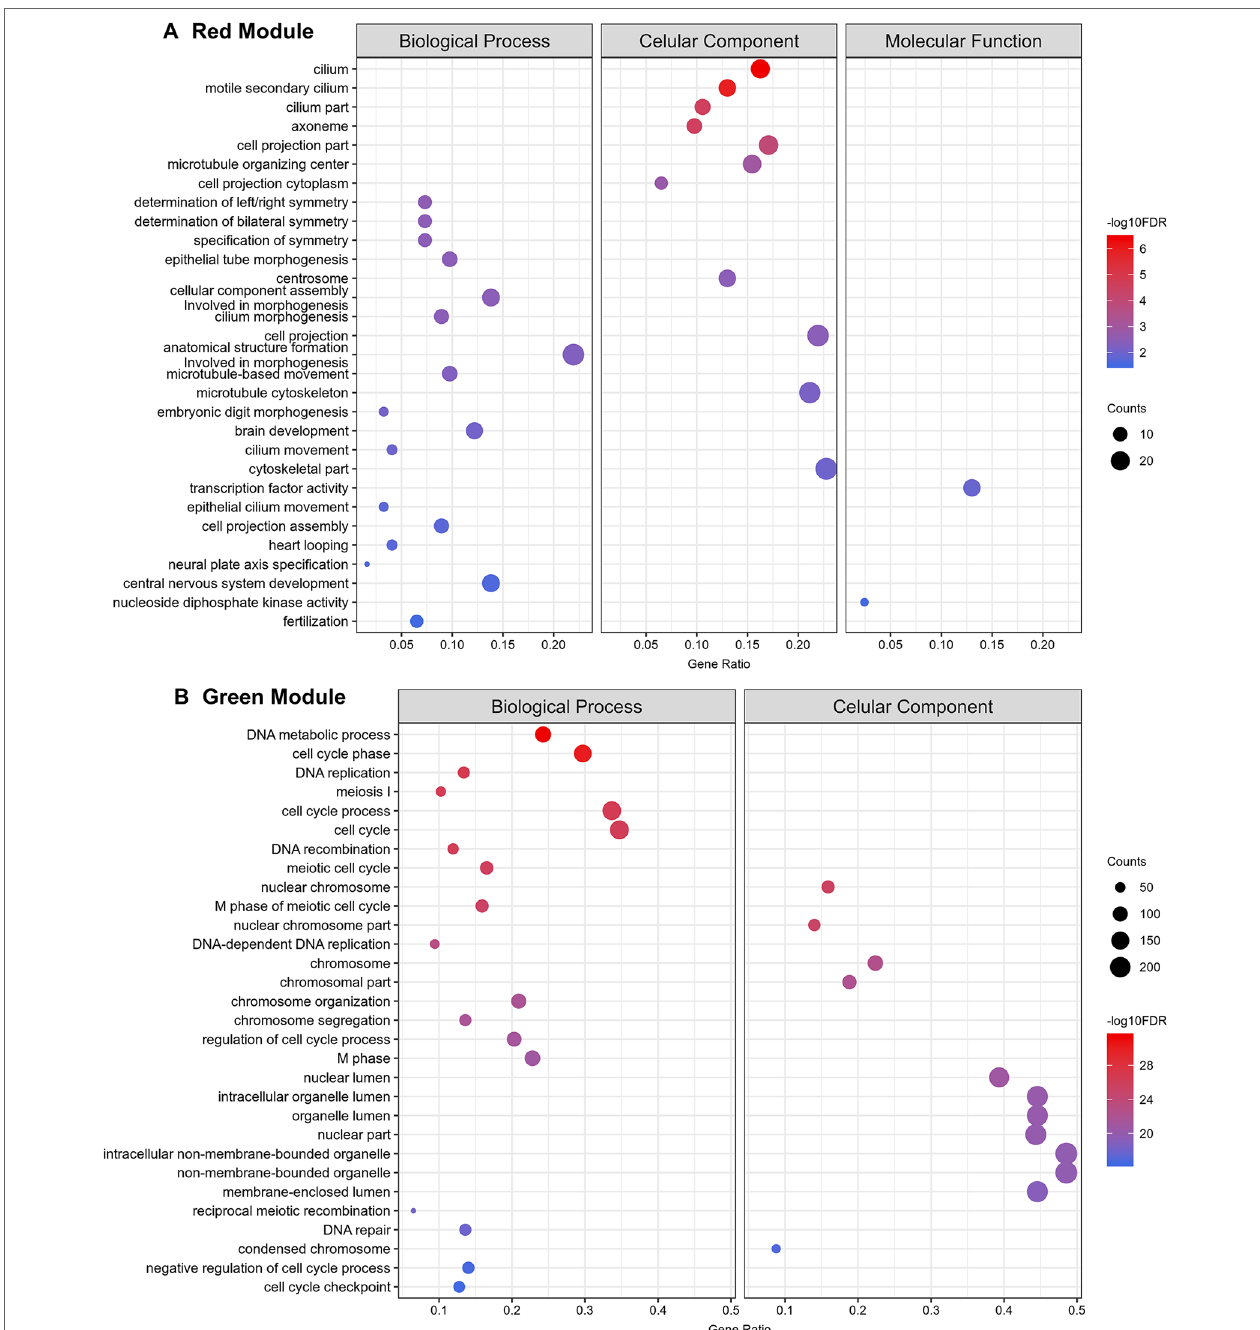
FIGURE 11 | Top 30 Gene Ontology most significantly enriched terms for protein-coding genes belonging to the red and green co-expression network modules. At left are the enriched GO term annotations. For the (A) red (testes) and the (B) green (gonads) modules, the enriched GOs are separately represented into the three major GO term categories, namely Biological Process, Cellular Component and Molecular Function. No Molecular Function term was significantly enriched in the green module. The size of the circles is proportional to the number of genes (counts scale on the right) in each significantly enriched GO category, and the colors show the statistical significance of the enrichment, as indicated by the -log10 FDR values (color-coded scales at the